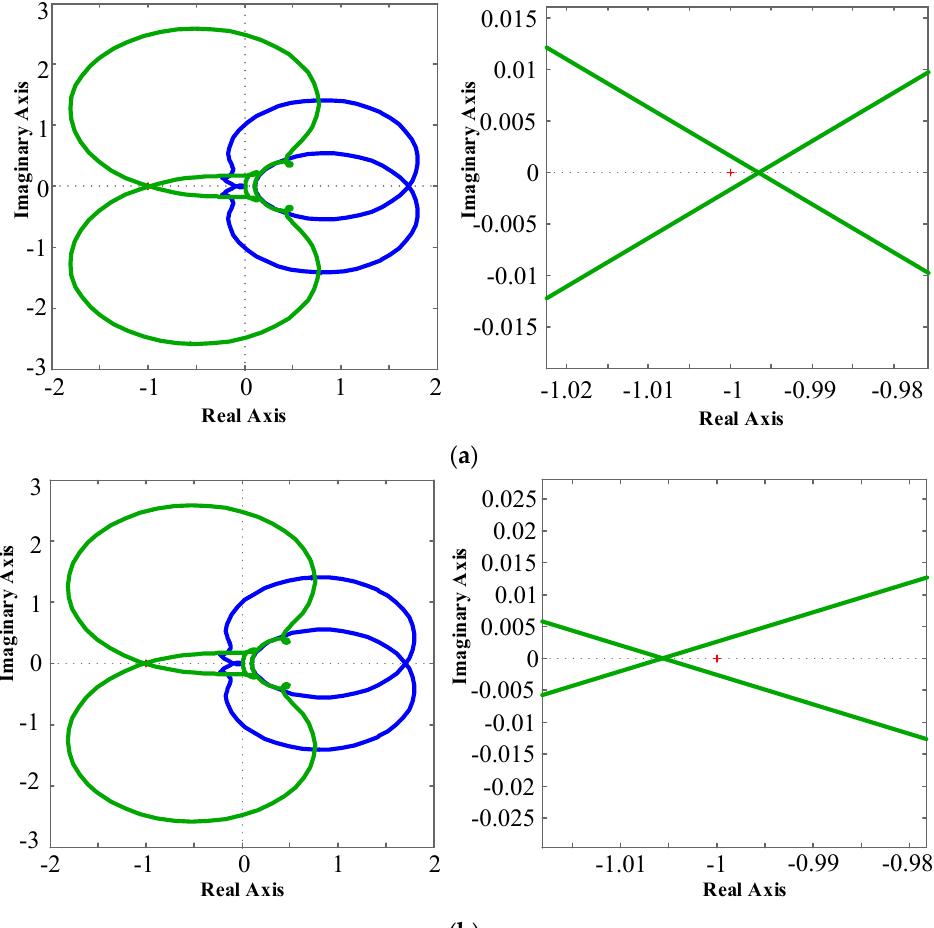
Figure 18. Nyquist plots of the feedback loop gain: ( a ) Nyquist plots in the stable case ( J = 0.293 kg · m 2 ), the graphs on the right are the magnified parts in ( − 1, j0). The point ( − 1, j0) is not enclosed by the curve, and the system is thus stable; ( b ) Nyquist plots in the unstable case ( J = 0.294 kg · m 2 ), the graphs on the right are the magnified parts in ( − 1, j0), which is enclosed by the curve, and the system becomes unstable.